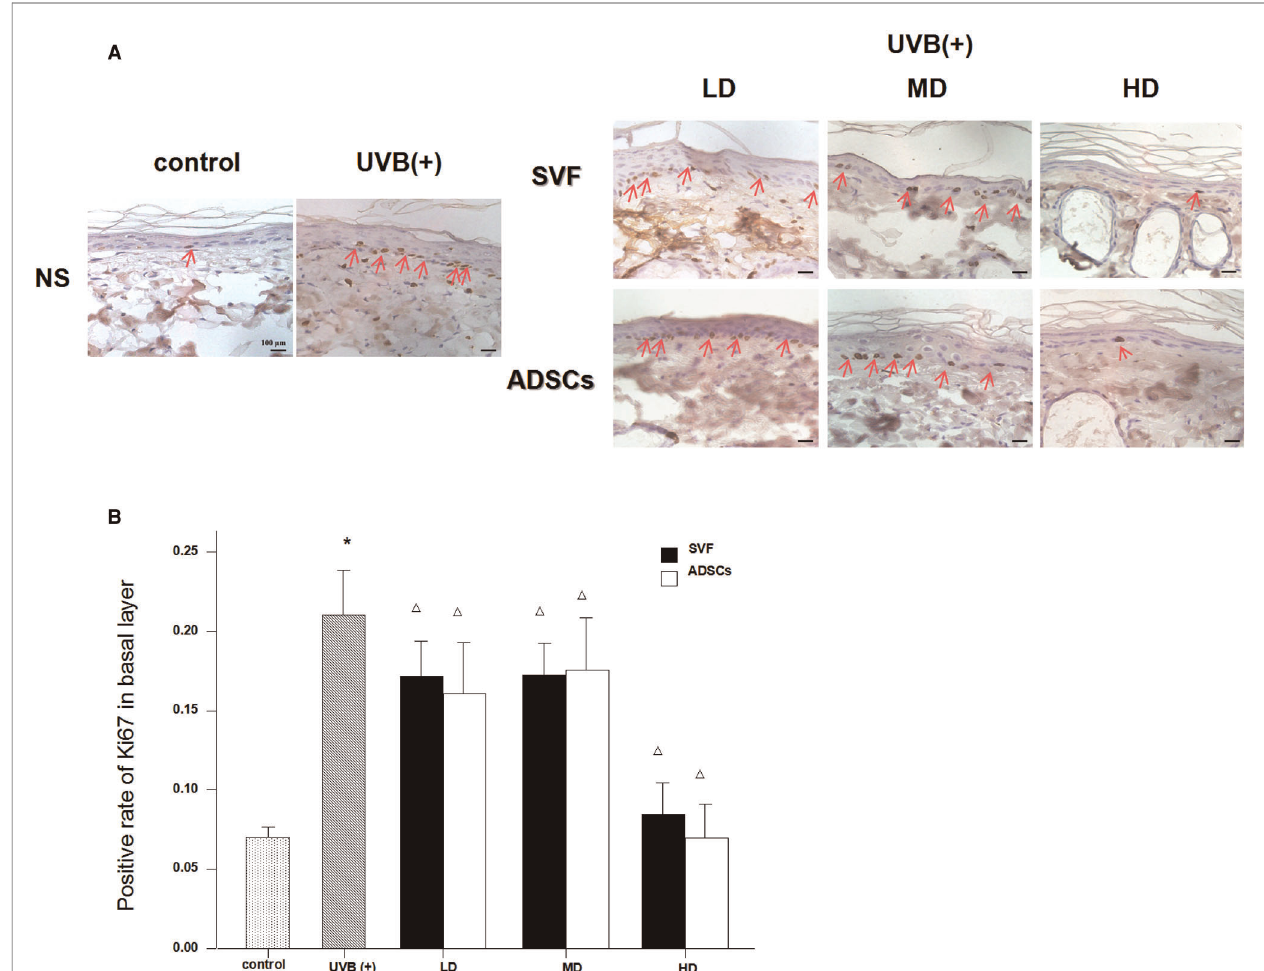
FIGURE 4 | Ki67 immunostain showed the proliferation of basal cell nuclei that treated with ADSCs and SVF after 7 days (×400). ( A ) UVB exposure stimulated abnormal proliferation of the basal layer cells. SVF and ADSCs treatment decreased the abnormal proliferation. ( B ) All of the treated groups had lower proliferation rates ( p <0.05). The ef fi cacy was signi fi cantly higher in the HD treatment group. No difference was observed in the matched groups between SVF and ADSCs. Mean ± SD. n = 6. * P < 0.05 vs control group. △ P < 0.05 vs UVB (+)